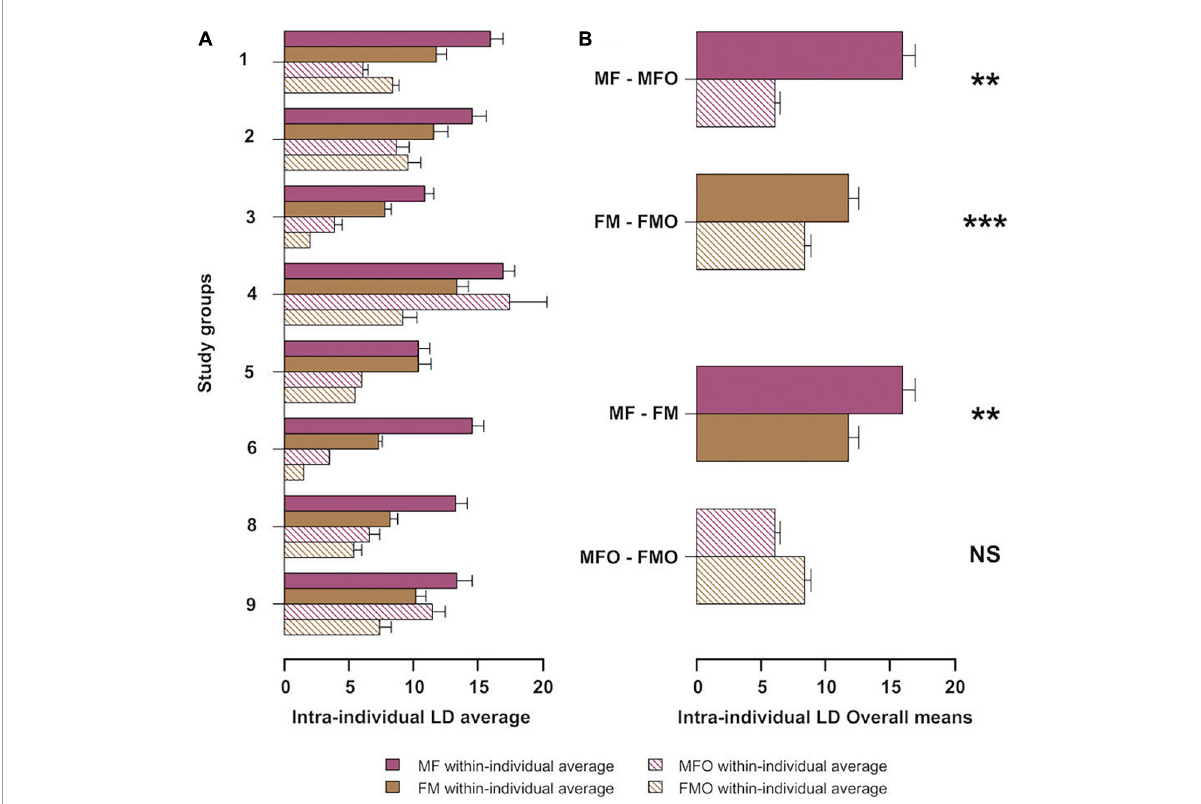
FIGURE3 The average Levenshtein distance (LD) for mothers and fathers in the two co-singing conditions: singing only with the pair-mate (MF, mothers’ contribution when duetting with fathers, FM, fathers’ contribution when duetting with mothers; color-filled barplot) and singing with the pair-mate and an offspring (MFO, mothers’ contribution when duetting with fathers and offspring; FMO, fathers’ contribution when duetting with mothers and offspring; striped barplot). Capped lines represent standard deviation. (A) LD within mothers and fathers for the eight studied groups (B) Overall LD average between mothers and fathers; t -test significance at p < 0.001 is denoted by ***, at p = 0.005, and p = 0.004 is denoted by